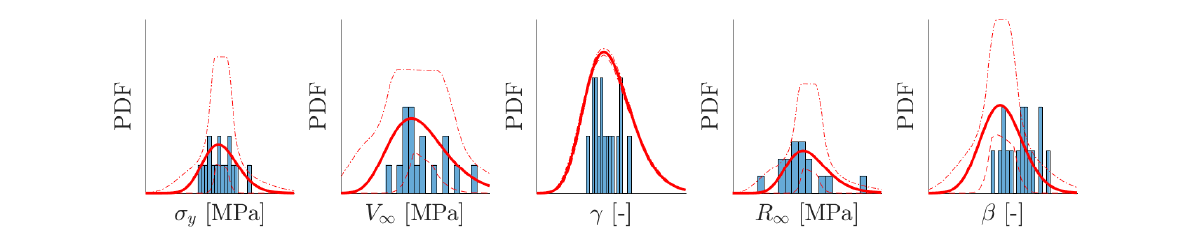
Figure 5. Verification: Histograms of synthetic experimental inputs and identified parameters’ PDF corresponding to hyperparameters’ means accompanied by bounds corresponding to 90 % of hyperparameters’ values.